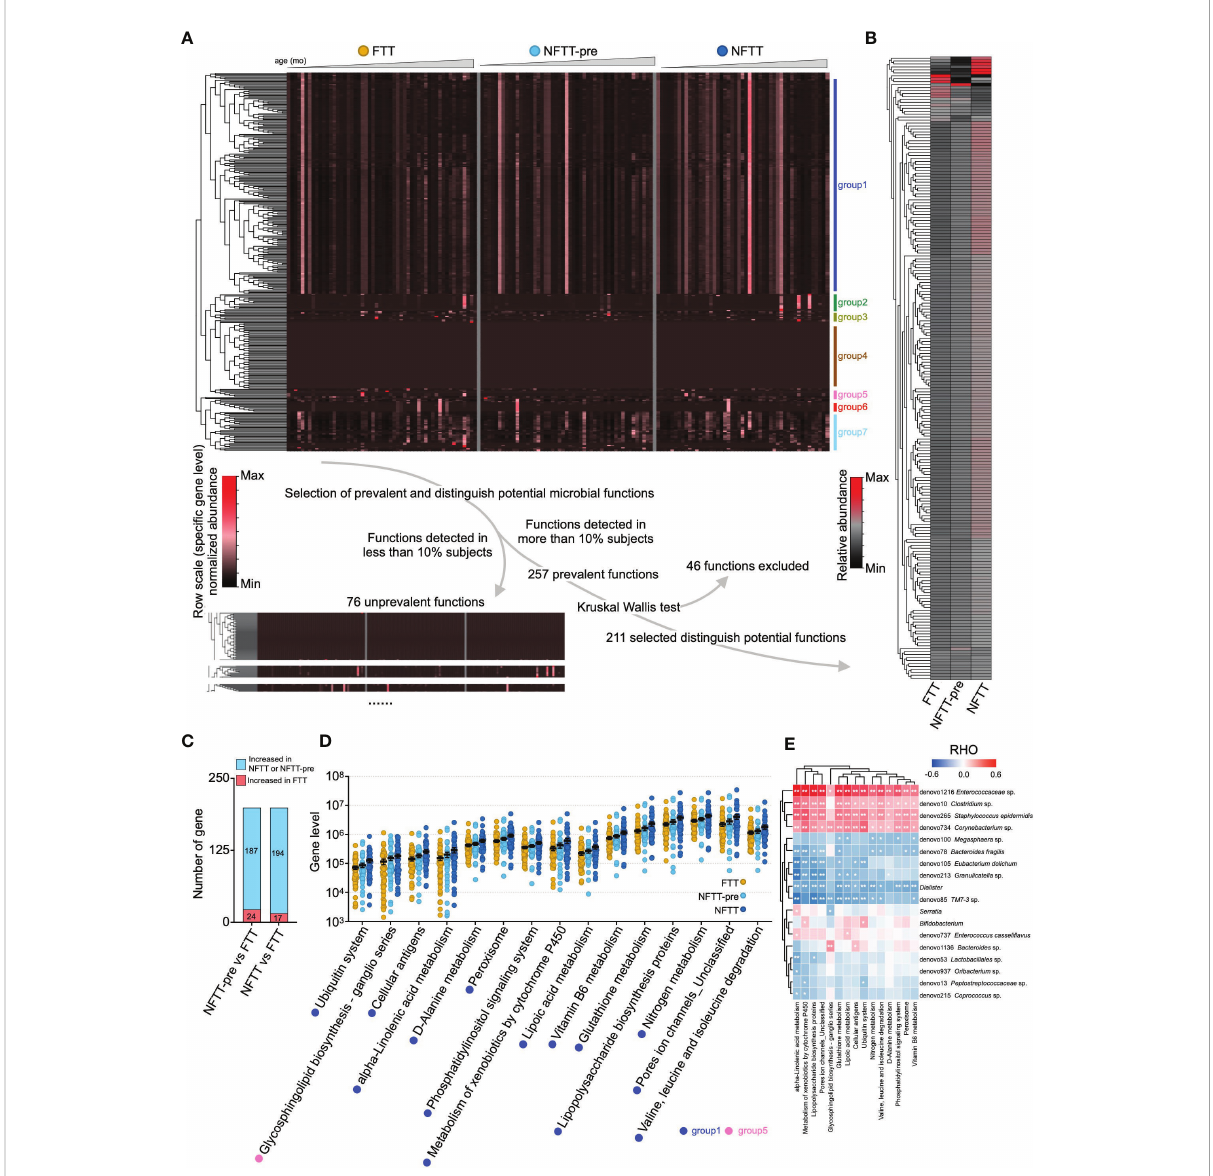
FIGURE 4 Insuf fi cient microbial functions enrichment in the FTT and NFTT-pre groups compared to that in the NFTT group. (A) Overview of the gut microbial functions in the FTT, NFTT-pre and NFTT groups. Heatmap (above) indicates the relative abundance of the 333 microbial functions predicted using the PICRUSt against the KEGG pro fi le. Samples are arranged from younger (left) to older (right), and the functions are clustered according the genetic sequential (by age) enrichment into 7 groups. Route (below) indicates the strategy for the selection of the 211 distinguished potential functions. (B) Relative abundance of the 211 distinguished potential functions in the FTT, NFTT-pre, and NFTT groups. (C) Brief statistical summary of the microbial functional changes between FTT and the other 2 groups. (D) Relative abundance of the 15 signi fi cant altered microbial functions across groups. Mean values ± SEM are plotted. Kruskal-Wallis test, * p < 0.05 and ** p < 0.01. (E) The heatmap of the correlations between the gut microbial functions and the signi fi cant altered develop- or age-related microbial taxa (revealed in Figure 3). Based on Spearman ’ s correlation coef fi cient, * p < 0.05, ** p <